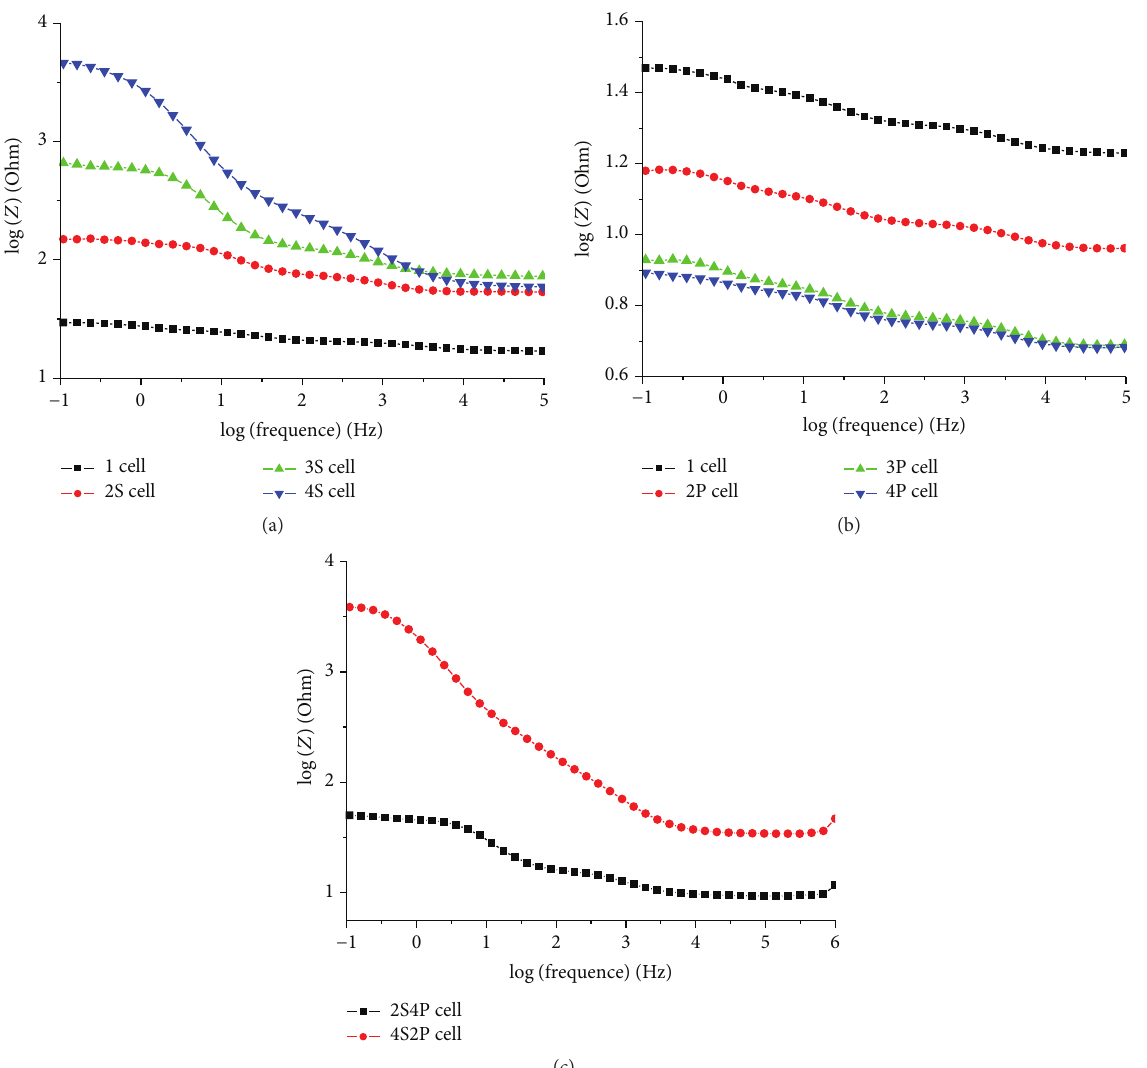
Figure 9: Bode impedance plots based on different DSSC model assemblies (a) series modules; (b) parallel modules; (c) series-parallel